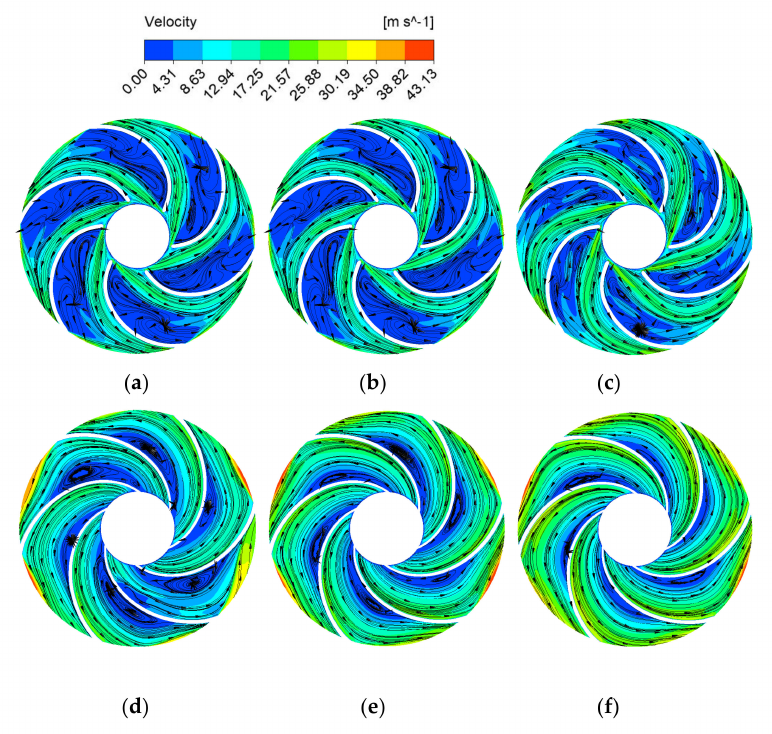
Figure 11. Comparison of the velocity and the streamline of the midsection of the impeller. ( a ) 0.8 Q d of the initial pump, ( b ) 1.0 Q d of the initial pump, ( c ) 1.2 Q d of the initial pump, ( d ) 0.8 Q d of the